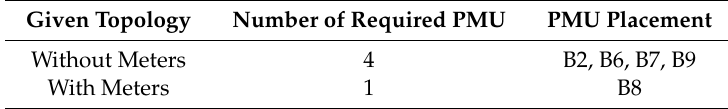
Table 1. PMU placement to ensure cyber security with / without conventional meters in IEEE 14-bus system.